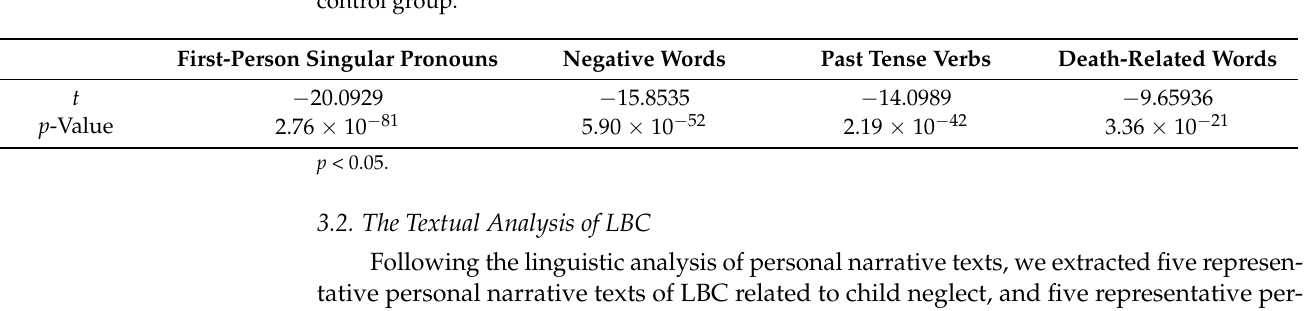
Table 6. Bilateral t -test results of personal narrative text differences between the LBC group and the control group.